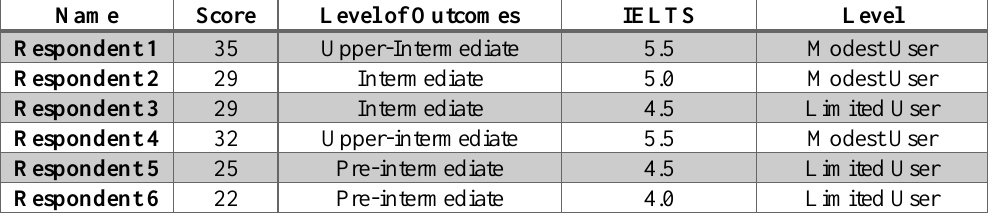
Table 1. Student’s Placement Test